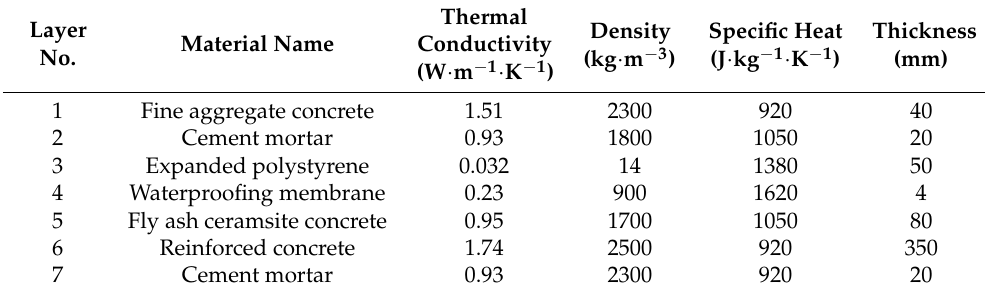
Table 1. Performance parameters of roof components [15,18].